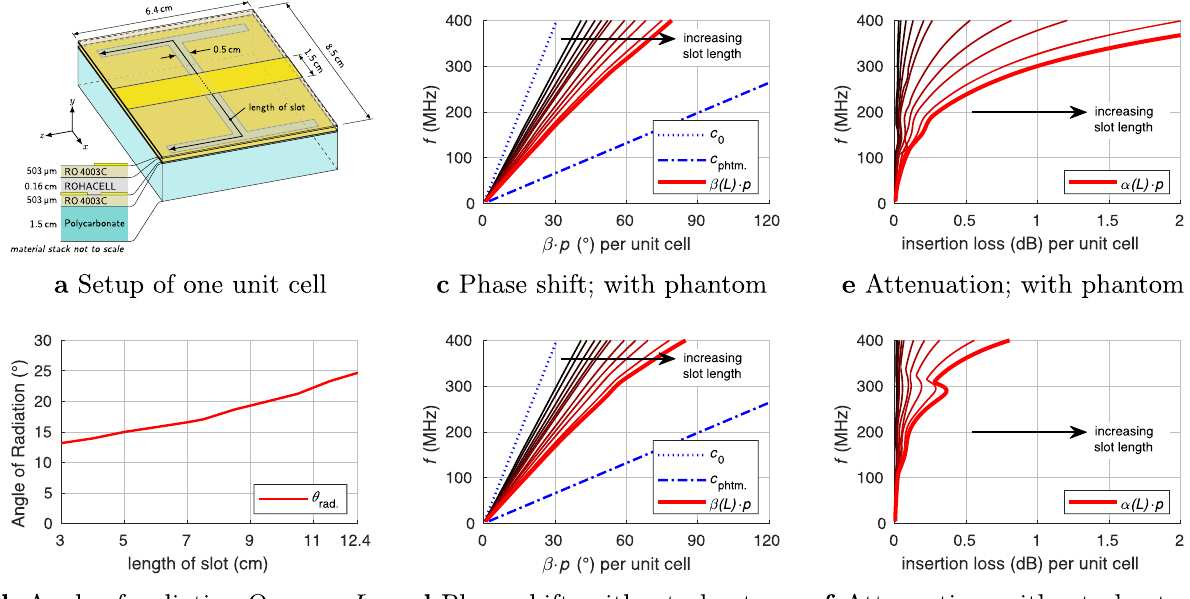
Fig. 4 A parametric numerical investigation of dispersion characteristics based on single unit cell. Geometry of the unit cell ( a ), angle θ rad of the leaky- wave radiation for the loaded transmission line ( b ), phase shift ( β ·p ) and insertion loss (dB) ( α (cid:2) p (cid:2) 20 log ð 10 Þ (cid:3) 1 ) in the microstrip leaky-wave transmission line per unit cell ( c , d – f ). The length of the slot is varied from 3 cm to 12.4 cm. In cases c , e , the transmission line is placed on a phantom while cases d , f represent the free space environment of the transmission line. The bold curves are for the LWA with an optimal length of 12.4